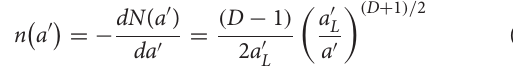
deviate from the fractal power-law behavior [e.g., Equation